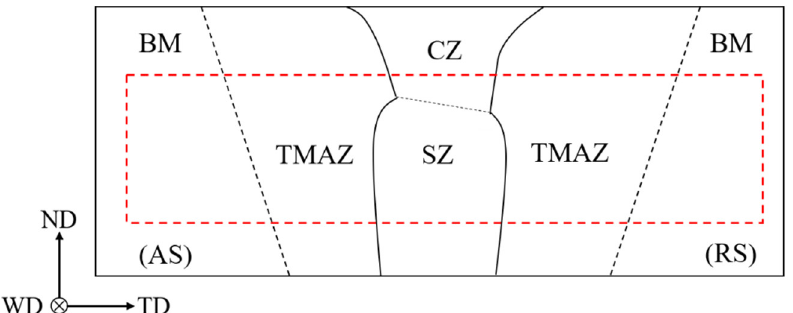
Figure 1. Illustration of the cross-section of friction stir welding (FSW) joint divided into several zones. retreating side (RS) and advancing stand (AS) stand for retreating side and advancing side, respectively. Base materials (BM), thermal-mechanical affected zone (TMAZ), crown zone (CZ) and stir zone (SZ) stand for base material, thermal-mechanical affected zone, crown zone and stir zone, respectively. Normal direction (ND), welding direction (WD) and transverse direction (TD) stand for normal direction, welding direction and transverse direction, respectively. The red dotted rectangle shows the sample position, and the thickness and tensile direction of samples were parallel to the ND and TD of FSW joint, respectively.